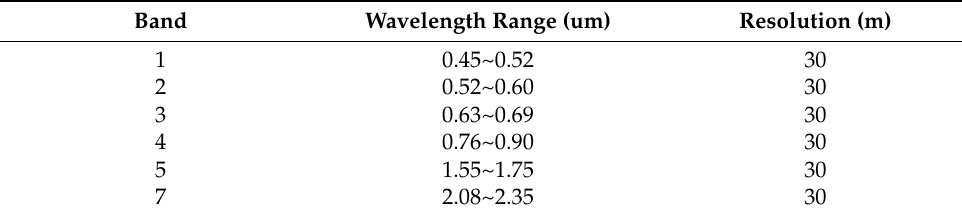
Table 2. Introduction of data information.